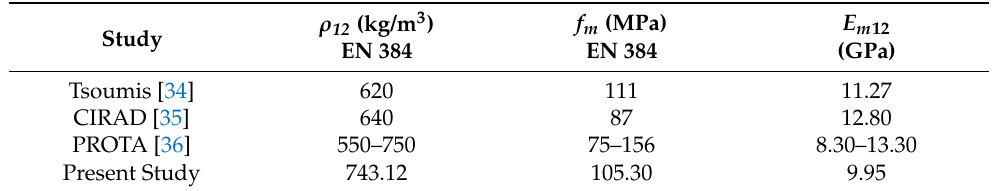
Table 9. Comparison between values of the so-called reference properties (density, modulus of elasticity in bending and bending strength) suggested by different